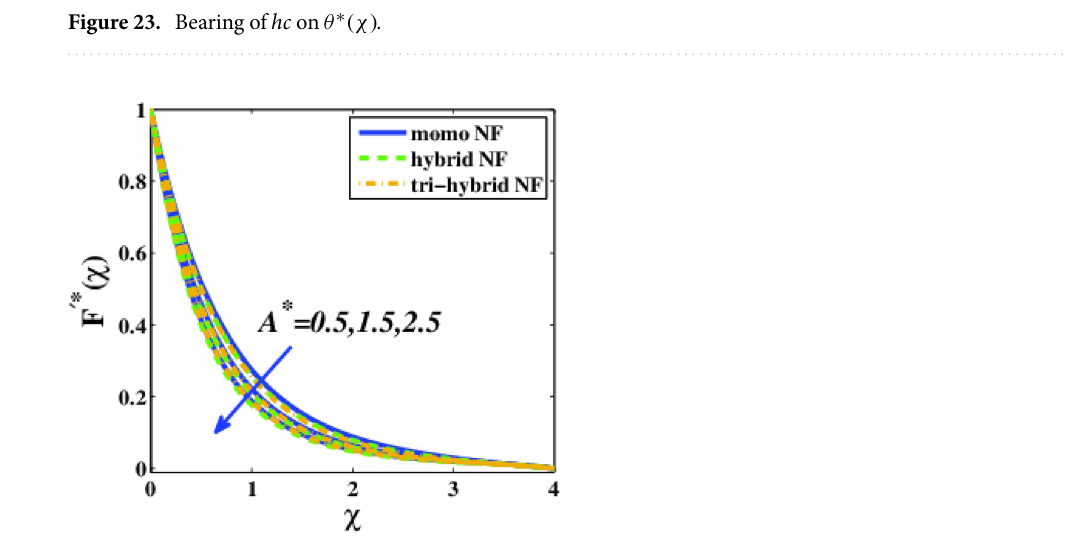
Figure 24. Impact of A ∗ on F ∗ ′ (χ)